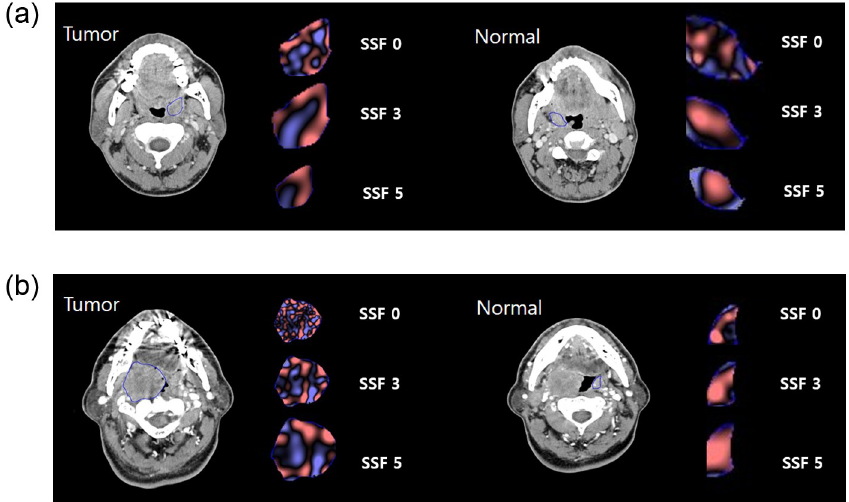
Fig 2. Imaging appearance and texture analysis features of early stage (a) and advanced stage (b) tonsil cancer. ROI for tonsil cancer and contralateral normal tonsils are demonstrated. Representative texture images with SSF 0, 3, 5 and coarse filters are shown. The red color in texture images indicates positive pixel values, and the blue color indicates negative pixel values, which are made after filtration according to filters of different sizes. The tumor side is more heterogeneous than the normal side and tends to have more negative pixel values. This feature is more noticeable with the SSF 0, fine